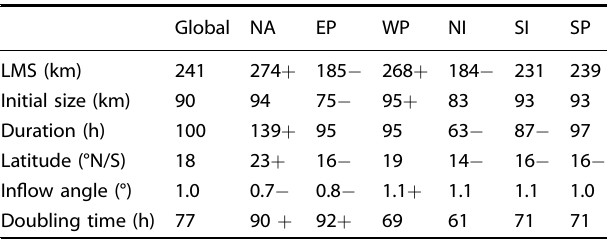
Table 5. Mean growth factors of global TCs. Global